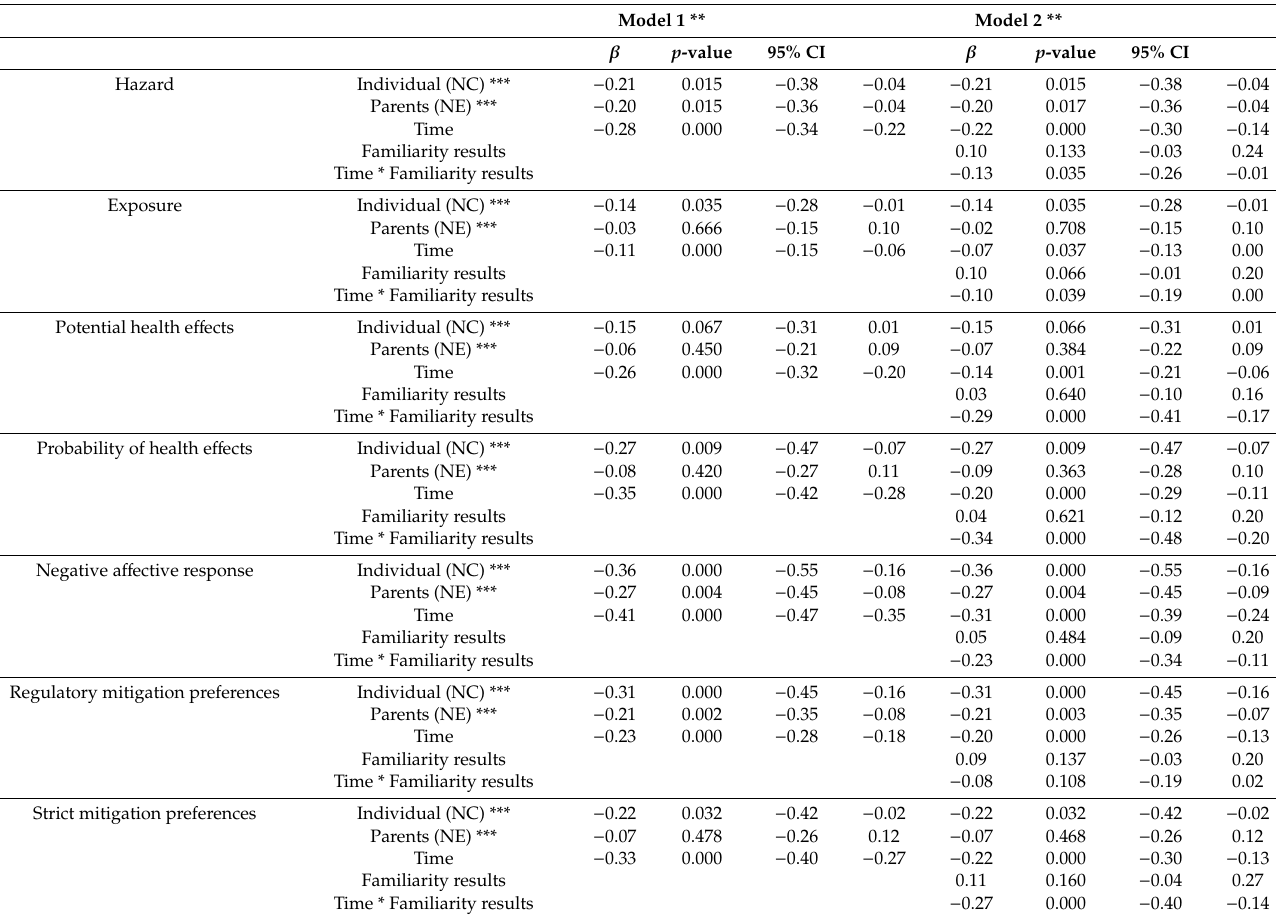
Table 4. Di ff erences in perceptions of the risk posed by rubber granulate and mitigation preferences between population groups *, changes in perceptions and preferences over time and the e ff ect of being familiar with the RIVM results on the changes in perceptions and preferences over time; the results of multilevel